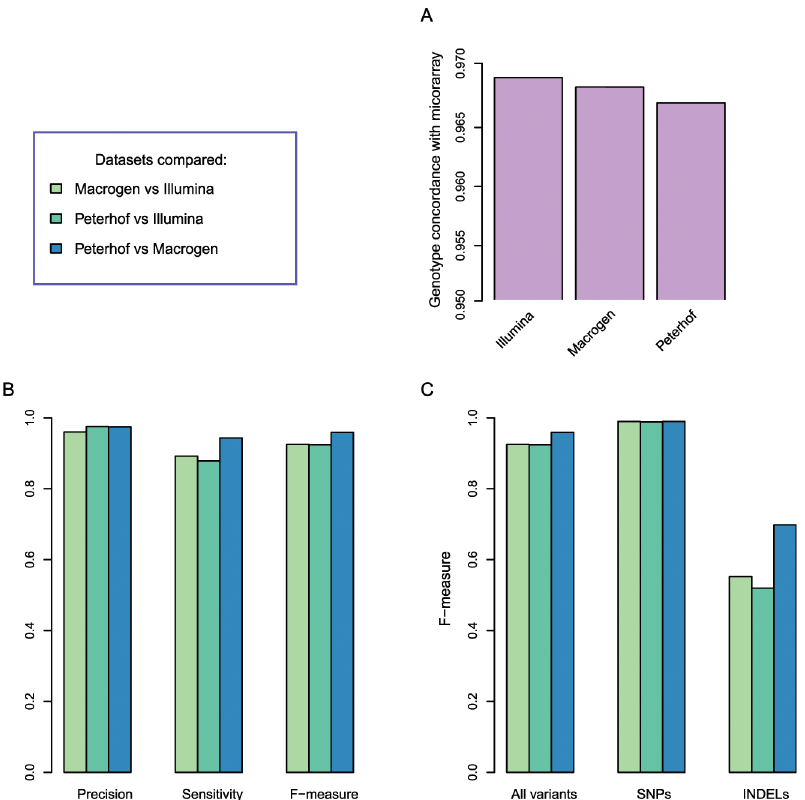
Fig 2. Genotype comparison. (A) Concordance of WGS genotypes with microarray genotypes. The concordance was estimated based on the trio data as the ratio of microarray SNPs with identical genotypes in WGS results. (B) Comparison of the three WGS datasets between each other in terms of precision, sensitivity and F-measure for pairwise comparisons. Color legend is given on the top right. (C) Concordance of genotypes in the three WGS datasets for all variants, SNPs and indels. Color legend is given on the top